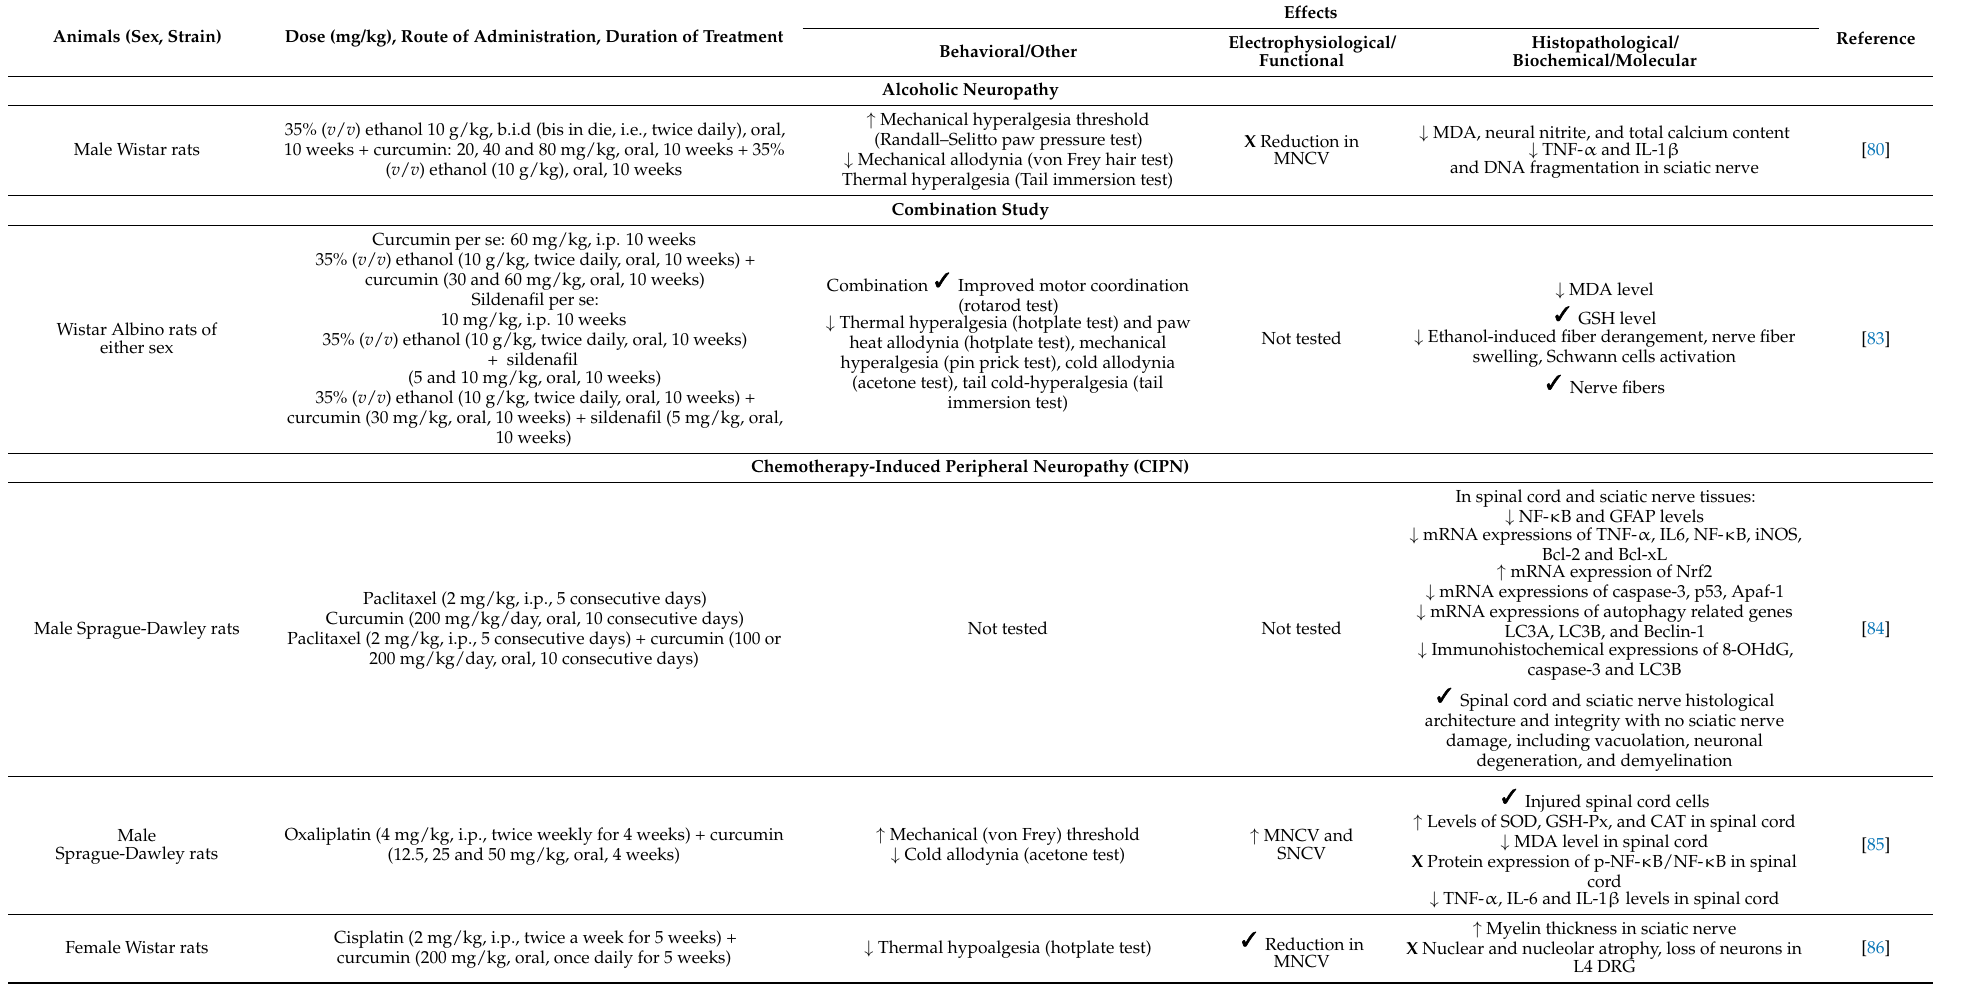
Table 2. Effects of curcumin on alcoholic neuropathy, chemotherapy-induced peripheral neuropathy (CIPN), and diabetic painful neuropathy (DPN). Animals (Sex, Strain)